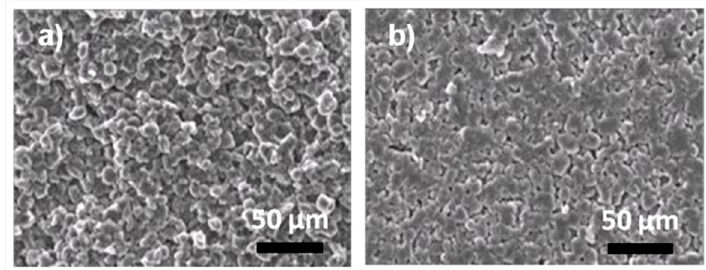
Figure 5. SEM images of the top surface morphology of anode electrodes for the pouch cell with ( a ) PE separator and ( b ) PIC separator after 10 cycles.